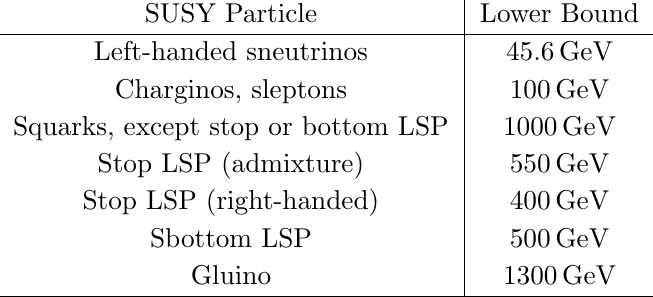
Table 1. Current lower bounds on the SUSY particle